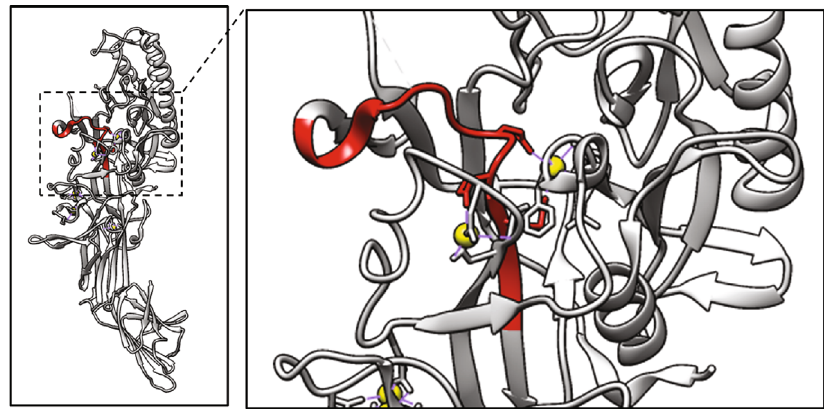
Figure 1: PAD2 ribbon structure (PDB ID: 4N2C). The epitope 341-YLNRGDRWIQDEIEFGY-357 is shown in red, while calcium is shown in yellow. The three-dimensional structure of PAD2 was edited and prepared using UCSF chimera as described previously